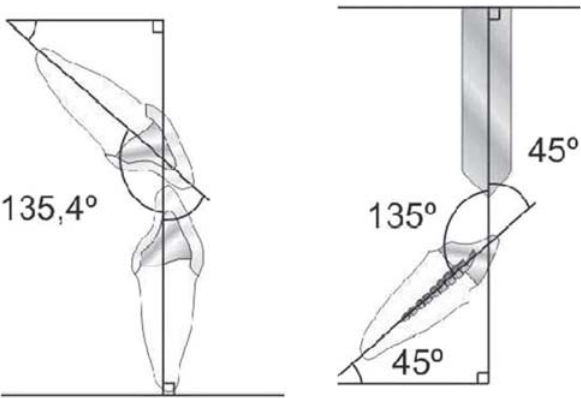
FIGURE 3- Device used for fixation and positioning of specimens subjected to fracture resistance tests in a universal testing